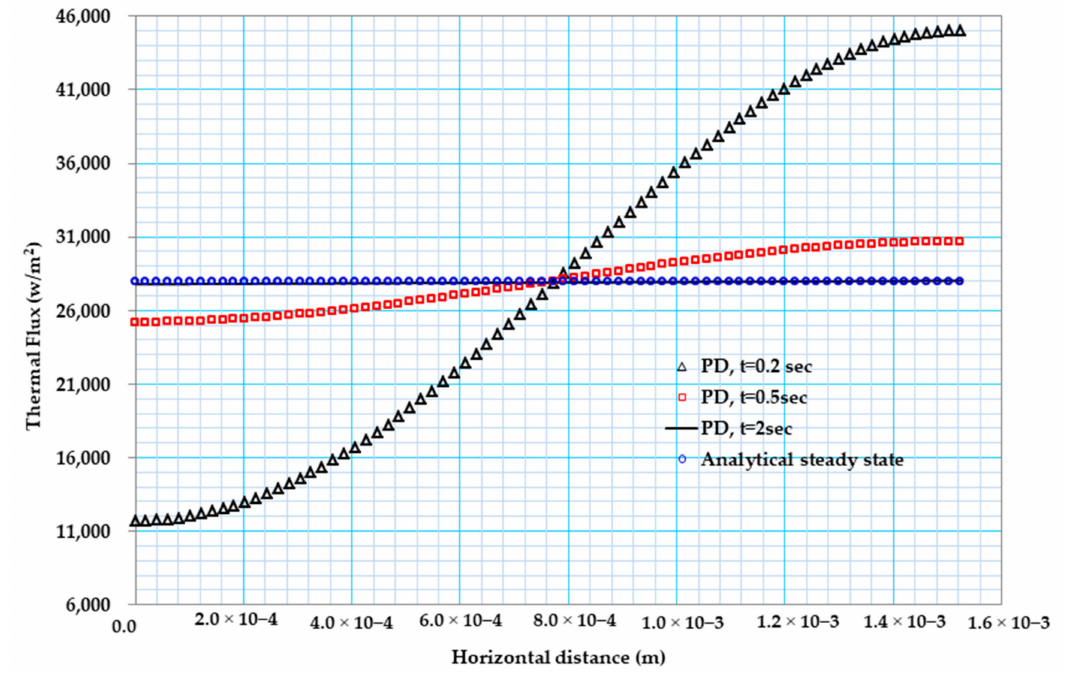
Figure 7. Heat flux (w / m2) distribution of bismuth telluride